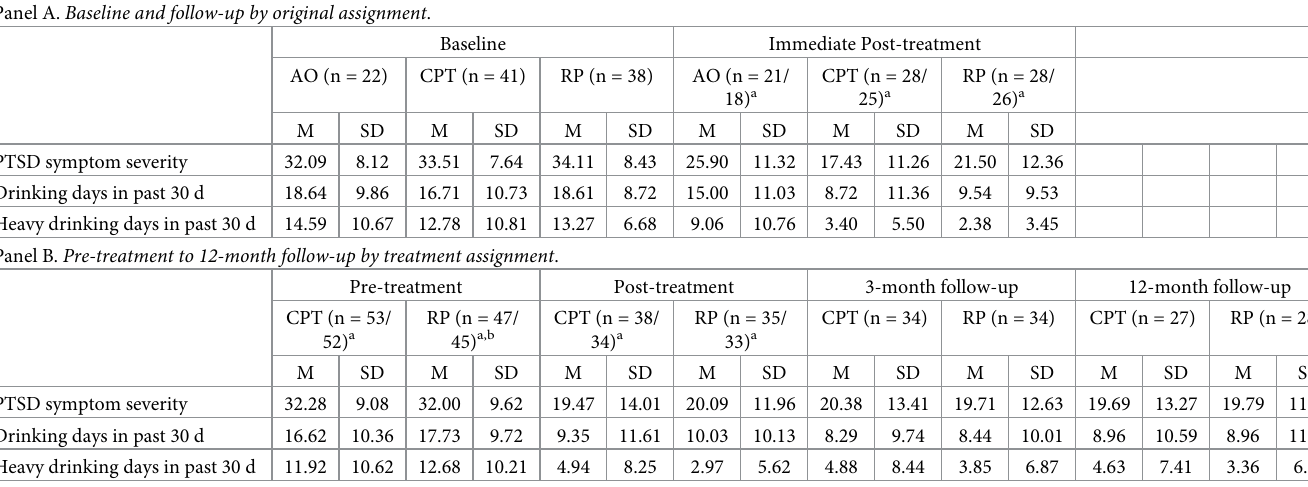
AO participants.